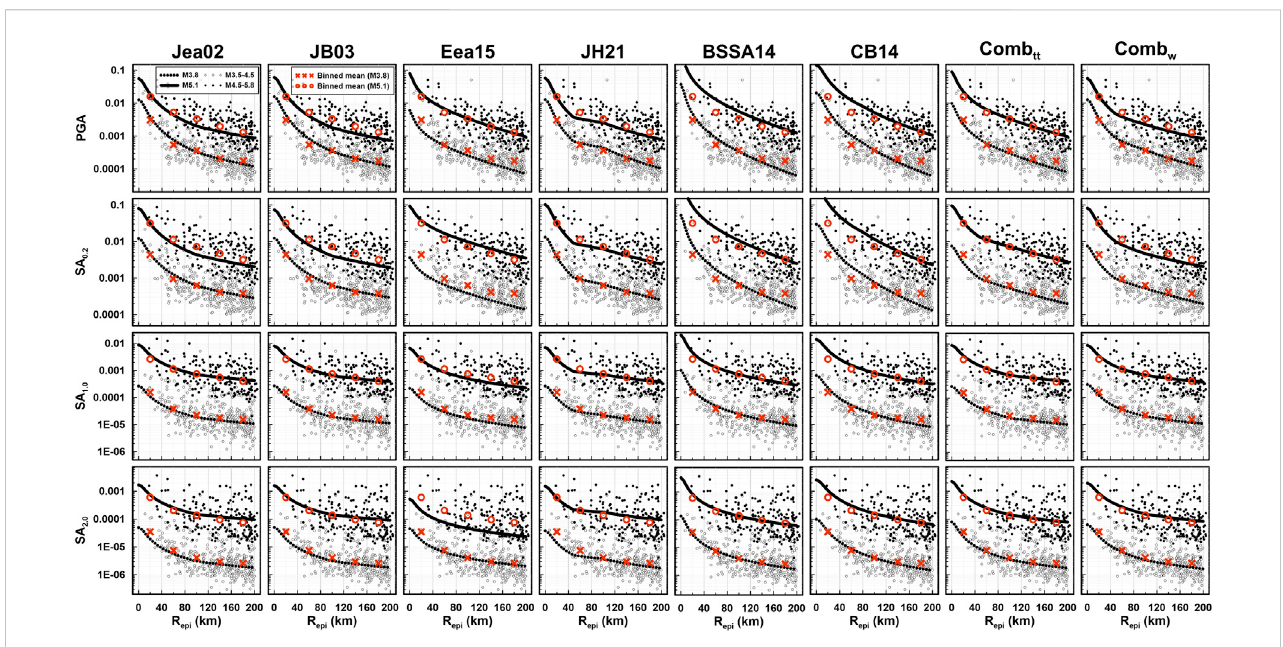
FIGURE 7 Comparison of four modi fi ed Korean GMMs and two global GMMs (Jea02, JB03, Eea15, JH21, BSSA14, and CB14) with combined GMMs minimizing σ tt and σ w (Comb tt and Comb w , respectively) for PGA, SA 0.2 , SA 1.0 , and SA 2.0 with M L = 3.6 and 5.1 varying R epi . Records and binned means for M L 3.5 – 4.5 and M L 4.5 – 5.8 are